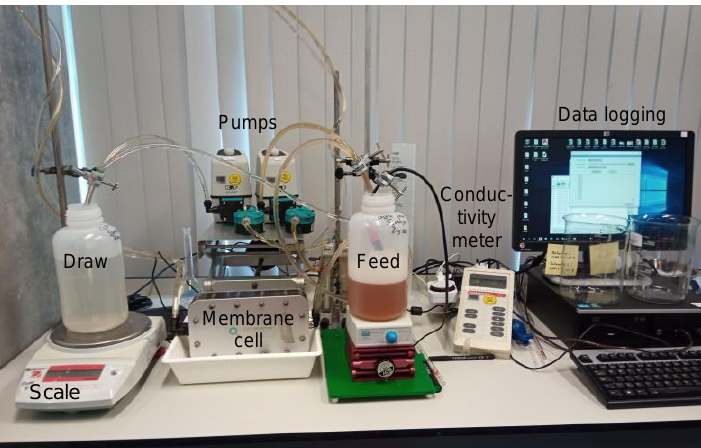
Figure 4. Image of the experimental FO set up. A membrane cell (Convergence Industry B.V., Enschede, The Netherlands) with two slits located on both ends of the membrane was used to hold the membrane, with an ef- fective membrane area of 0.006 m 2 (40 mm width, 150 mm length) and a 5 mm slit height. The membrane was used to filtrate with the active TFC layer facing the FS (FO mode). Diamond-shaped spacers with a thickness of 2 mm were used, two on top of each other at each side of the membrane. UPW, apple juice, manure or whey were used as FS (1.8 L each), which means an initial feed volume/membrane area of 300 L/m 2 . DSs (1 L) were prepared by dissolving NaCl in UPW at an initial concentrations of 1.2 or 3.6 M. The FS